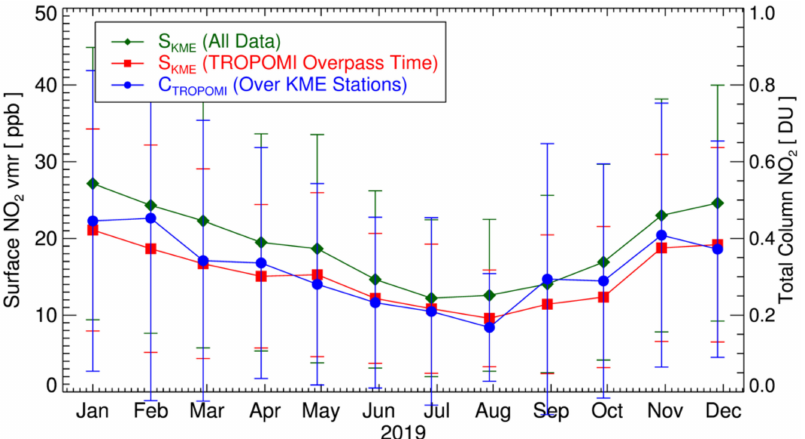
Figure 3. Monthly variations of surface NO 2 mixing ratio for 2019 measured by ground network of Korea Ministry of Environment ( S KME ), and tropospheric column NO 2 from TROPOMI ( C TROPOMI ). Green diamonds show monthly mean values of all data, and error bar indicates standard deviations. Red rectangles with error bars are those corresponding to the TROPOMI overpass time (~13:30 local time). Blue circles show monthly mean values of TROPOMI data over KME